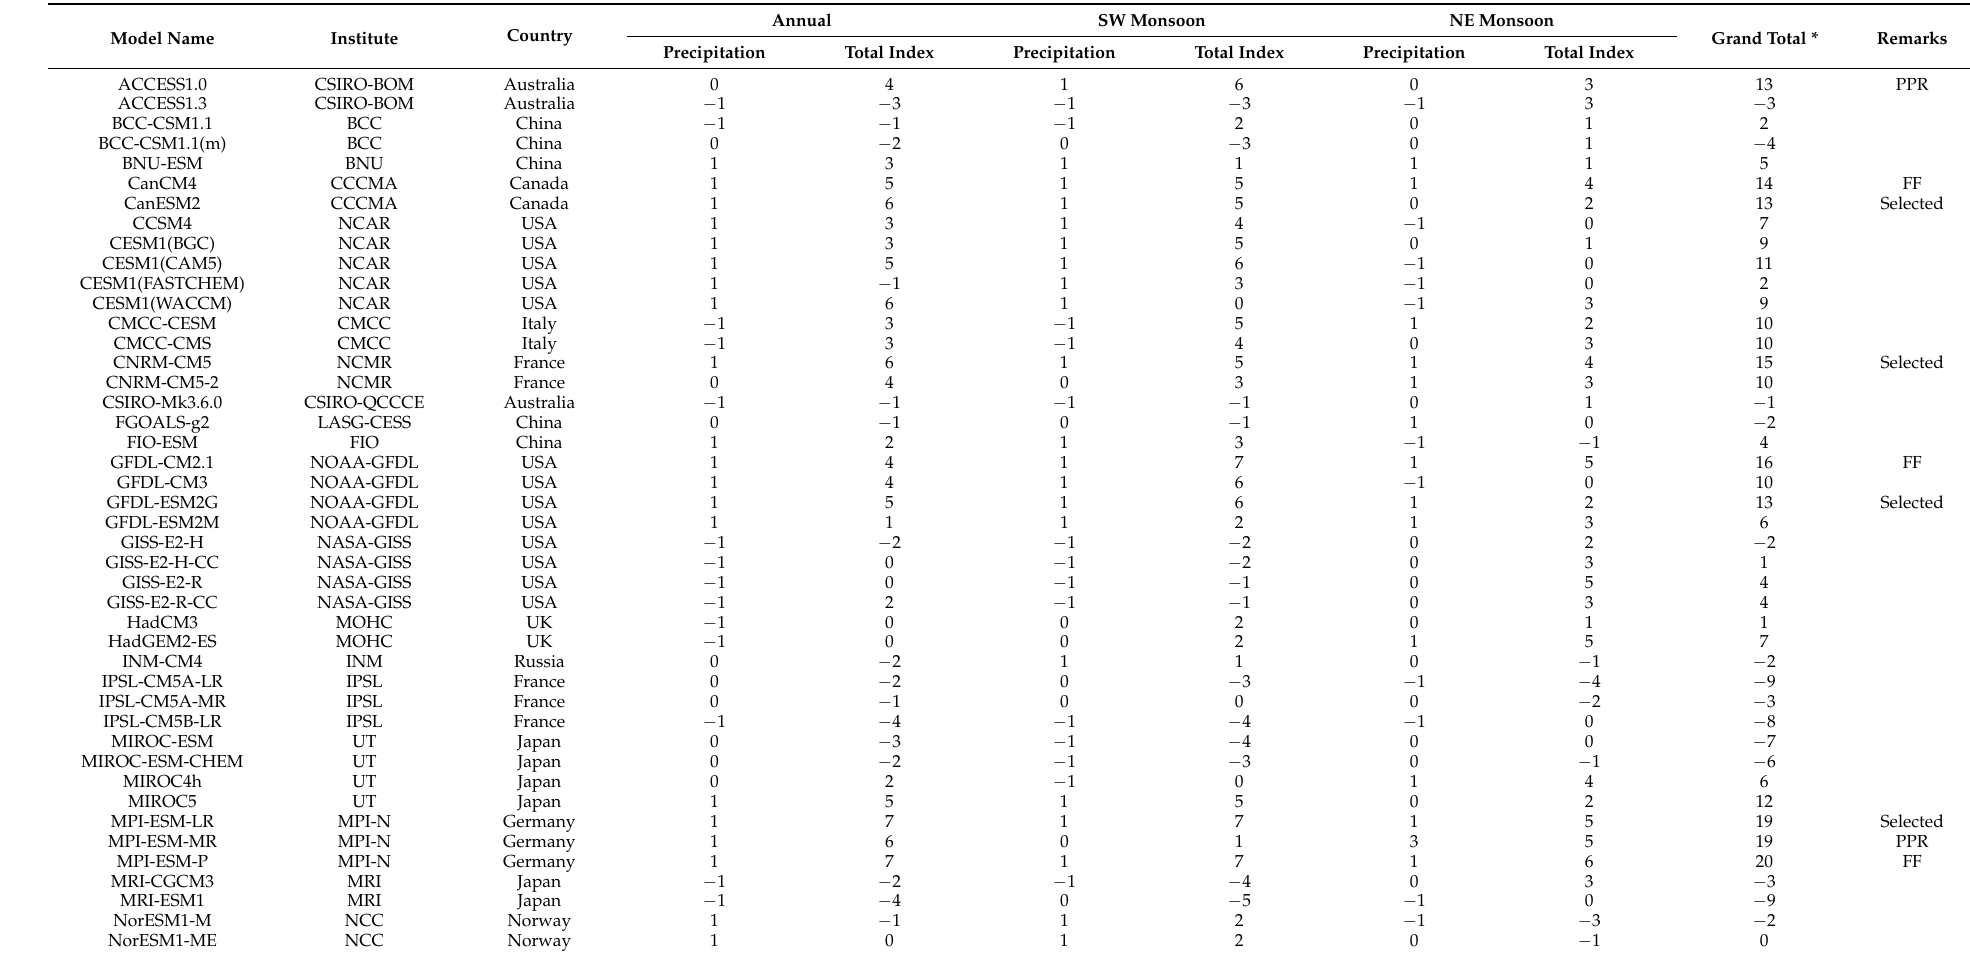
Table 1. Model selection summary for annual, SW monsoon, and NE monsoon period